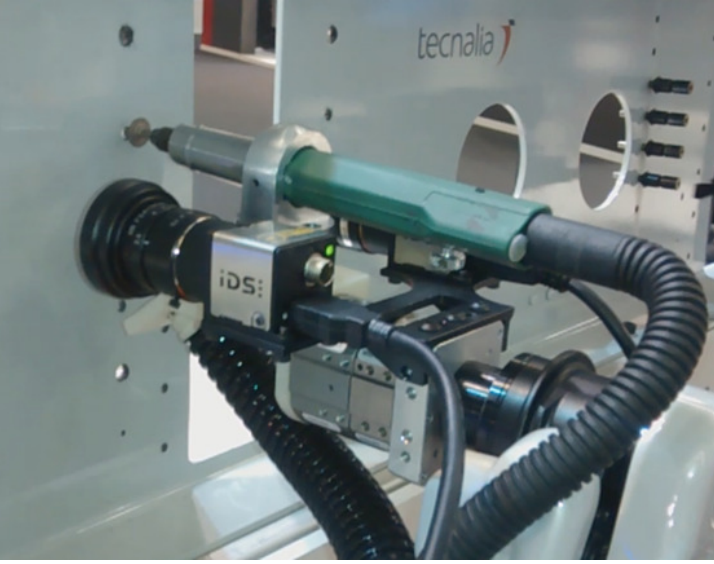
Figure 8. A drilled hole is deburred after detecting its position by